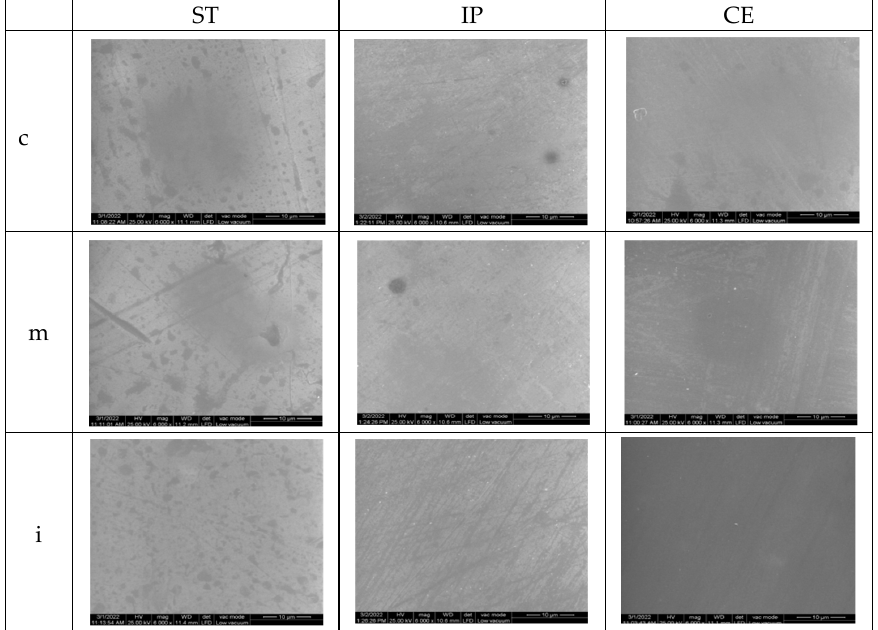
Figure 9. SEM images for glazed samples after aging.ST = STML, IP = IPS e.maxZirCAD CEREC/in Lab MT Multi, CE = CeramillZolidfx ML, c = cervical, m = medium, i = incisal.